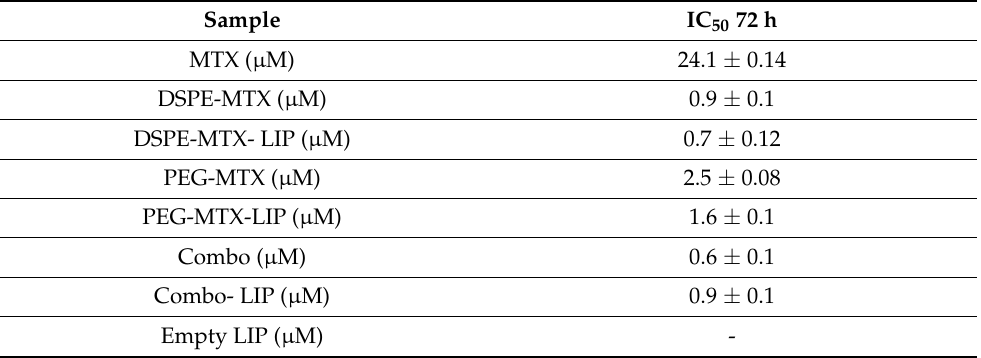
Table 4. IC 50 of MTX, DSPE-MTX, DSPE-MTX-LIP, empty LIP, PEG-MTX, PEG-MTX-LIP, Combo and Combo-LIP calculated on BMDMs 72 h after